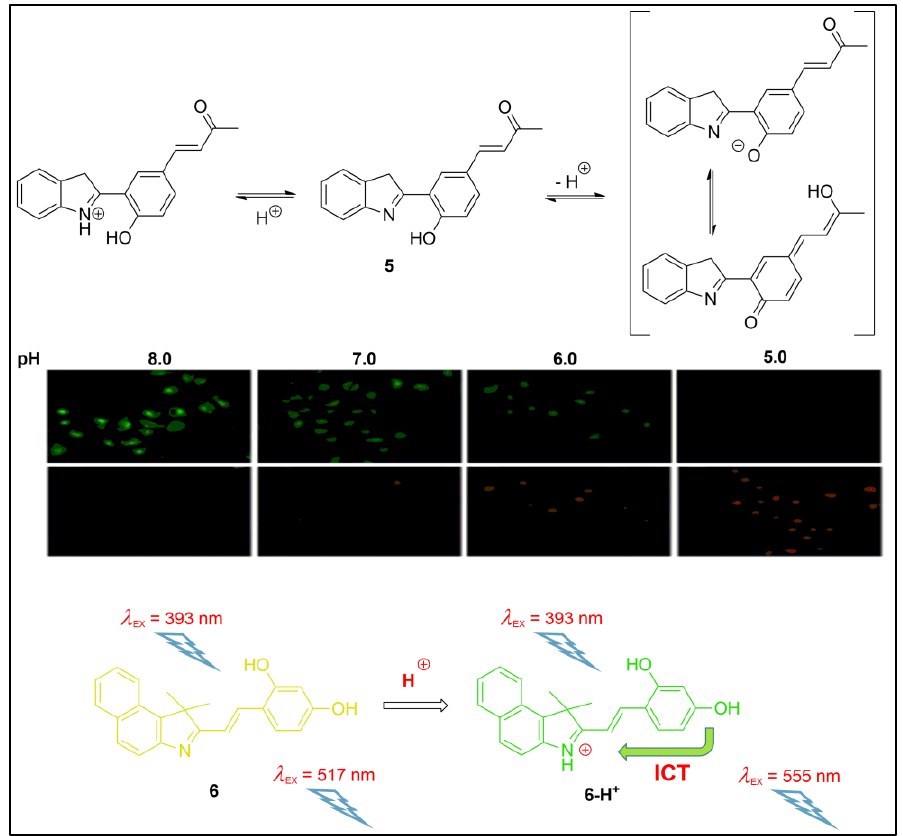
Figure 6. Acid – base equilibrium of probes 5 and 6 . Fluorescence images of MCF-7 cells pretreated with probe 5 (5 μ M) for 2 h and after incubated using PBS with various pH values for 20 min. The images are collected at 470 – 545 nm (upper row) and 545 – 650 nm (lower row). Adapted with permission from [48]. Copyright (2017) Elsevier.